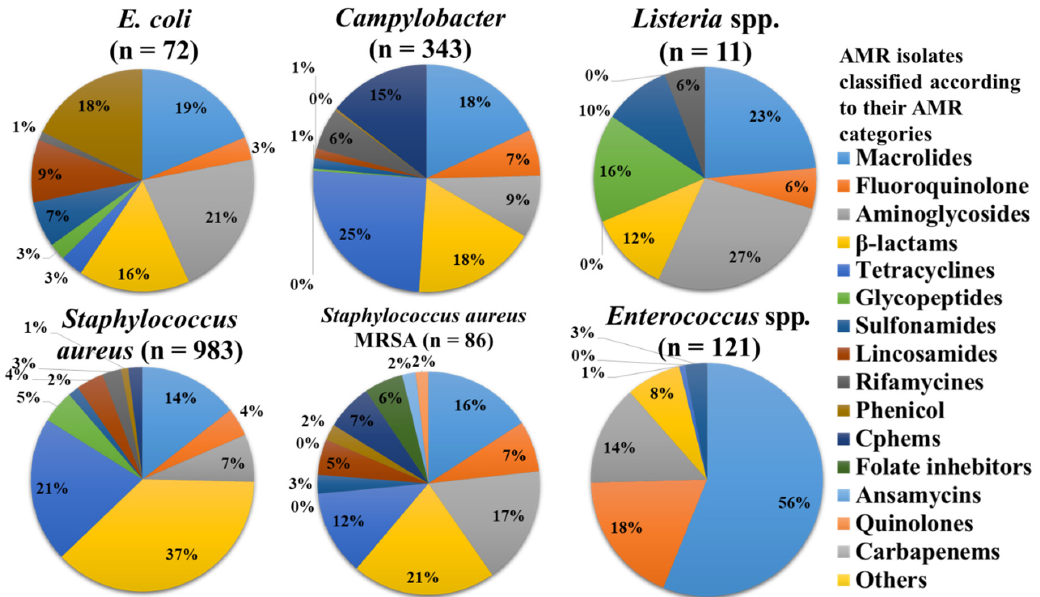
Figure 7. Based on the phenotypic AMR detected against the 16 major AM classes in the USA, distributions of AMR isolates of foodborne pathogens and indicator bacteria have been determined (n = 1616). (n = total number of food samples contaminated with certain bacteria).